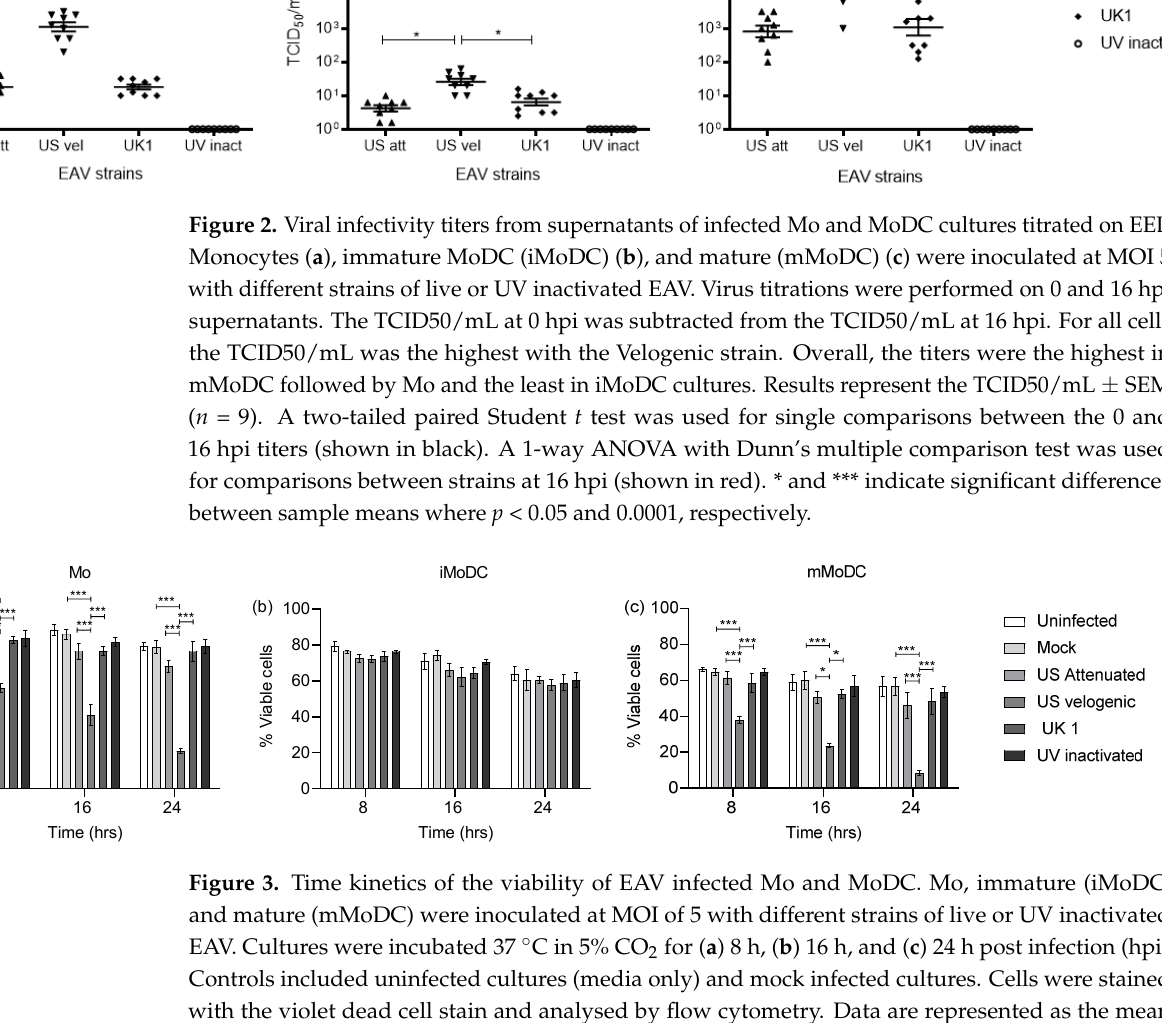
Figure 2. Viral infectivity titers from supernatants of infected Mo and MoDC cultures titrated on EEL. Monocytes ( a ), immature MoDC (iMoDC) ( b ), and mature (mMoDC) ( c ) were inoculated at MOI 5 with different strains of live or UV inactivated EAV. Virus titrations were performed on 0 and 16 hpi supernatants. The TCID50/mL at 0 hpi was subtracted from the TCID50/mL at 16 hpi. For all cells the TCID50/mL was the highest with the Velogenic strain. Overall, the titers were the highest in mMoDC followed by Mo and the least in iMoDC cultures. Results represent the TCID50/mL ± SEM ( n = 9). A two-tailed paired Student t test was used for single comparisons be- tween the 0 and 16 hpi titers (shown in black). A 1-way ANOVA with Dunn’s multiple comparison test was used for comparisons between strains at 16 hpi (shown in red). * and *** indicate significant differences between sample means where p < 0.05 and 0.0001, respectively.